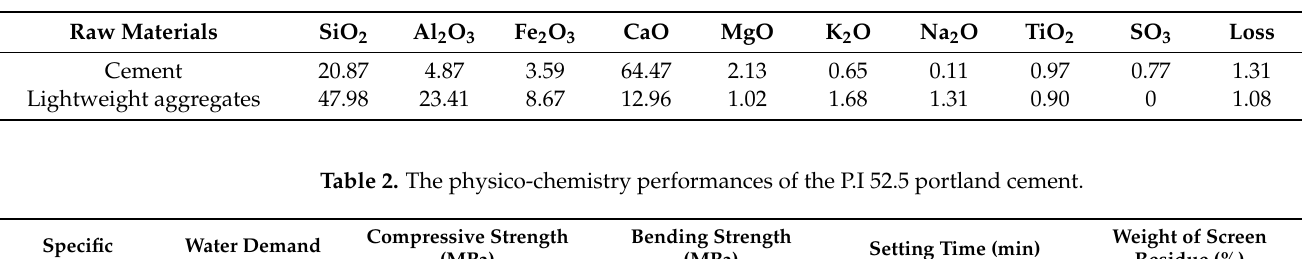
Table 1. The chemical compositions of the P.I 52.5 portland cement and high-performance spherical lightweight aggregates (wt%).